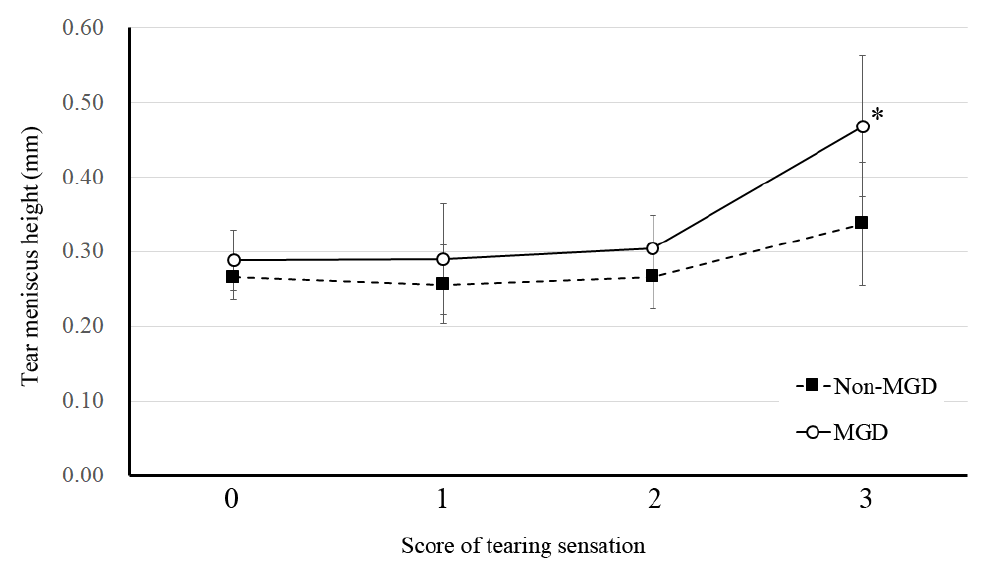
Figure 2. Relation between tear meniscus height (TMH) and frequency of tearing sensation in subjects with or without MGD. Data for TMH are means ± s.d. p -values were determined with a linear mixed-effects model (* p < 0.05).